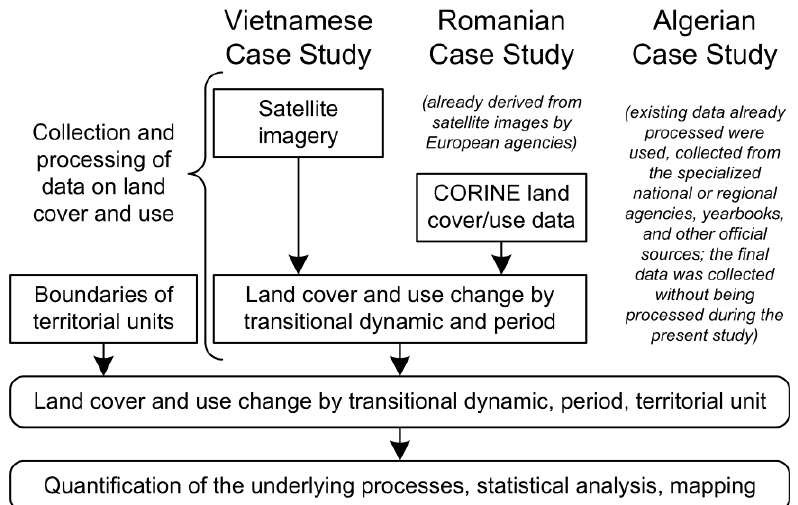
Figure 5. Schematics of the overall methodology of the study. The image focuses on the sources and level of processing data: satellite images in the Vietnamese case study, GIS data derived from satellite imagery in the Romanian case study, and already processed data from the national statistical o ffi ce in Algeria, and also indicates the subsequent processing of